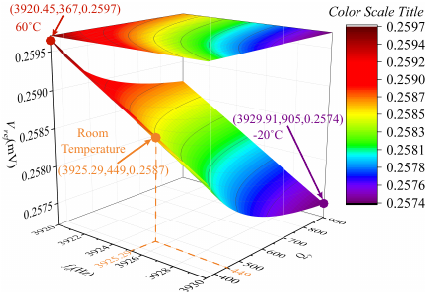
Figure 8. The effect of ω d and Q y on V ref .